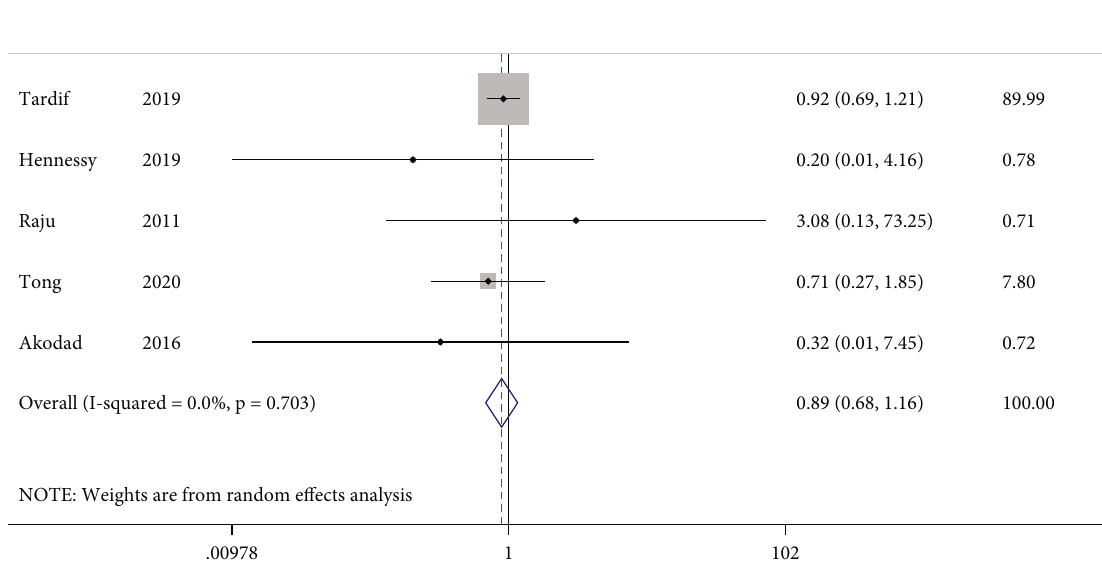
Figure 4: Forest plot displaying risk ratio and 95% con fi dence intervals for the impact of colchicine on myocardial infarction in patients with acute coronary syndrome. RR: risk ratio; CI: con fi dence